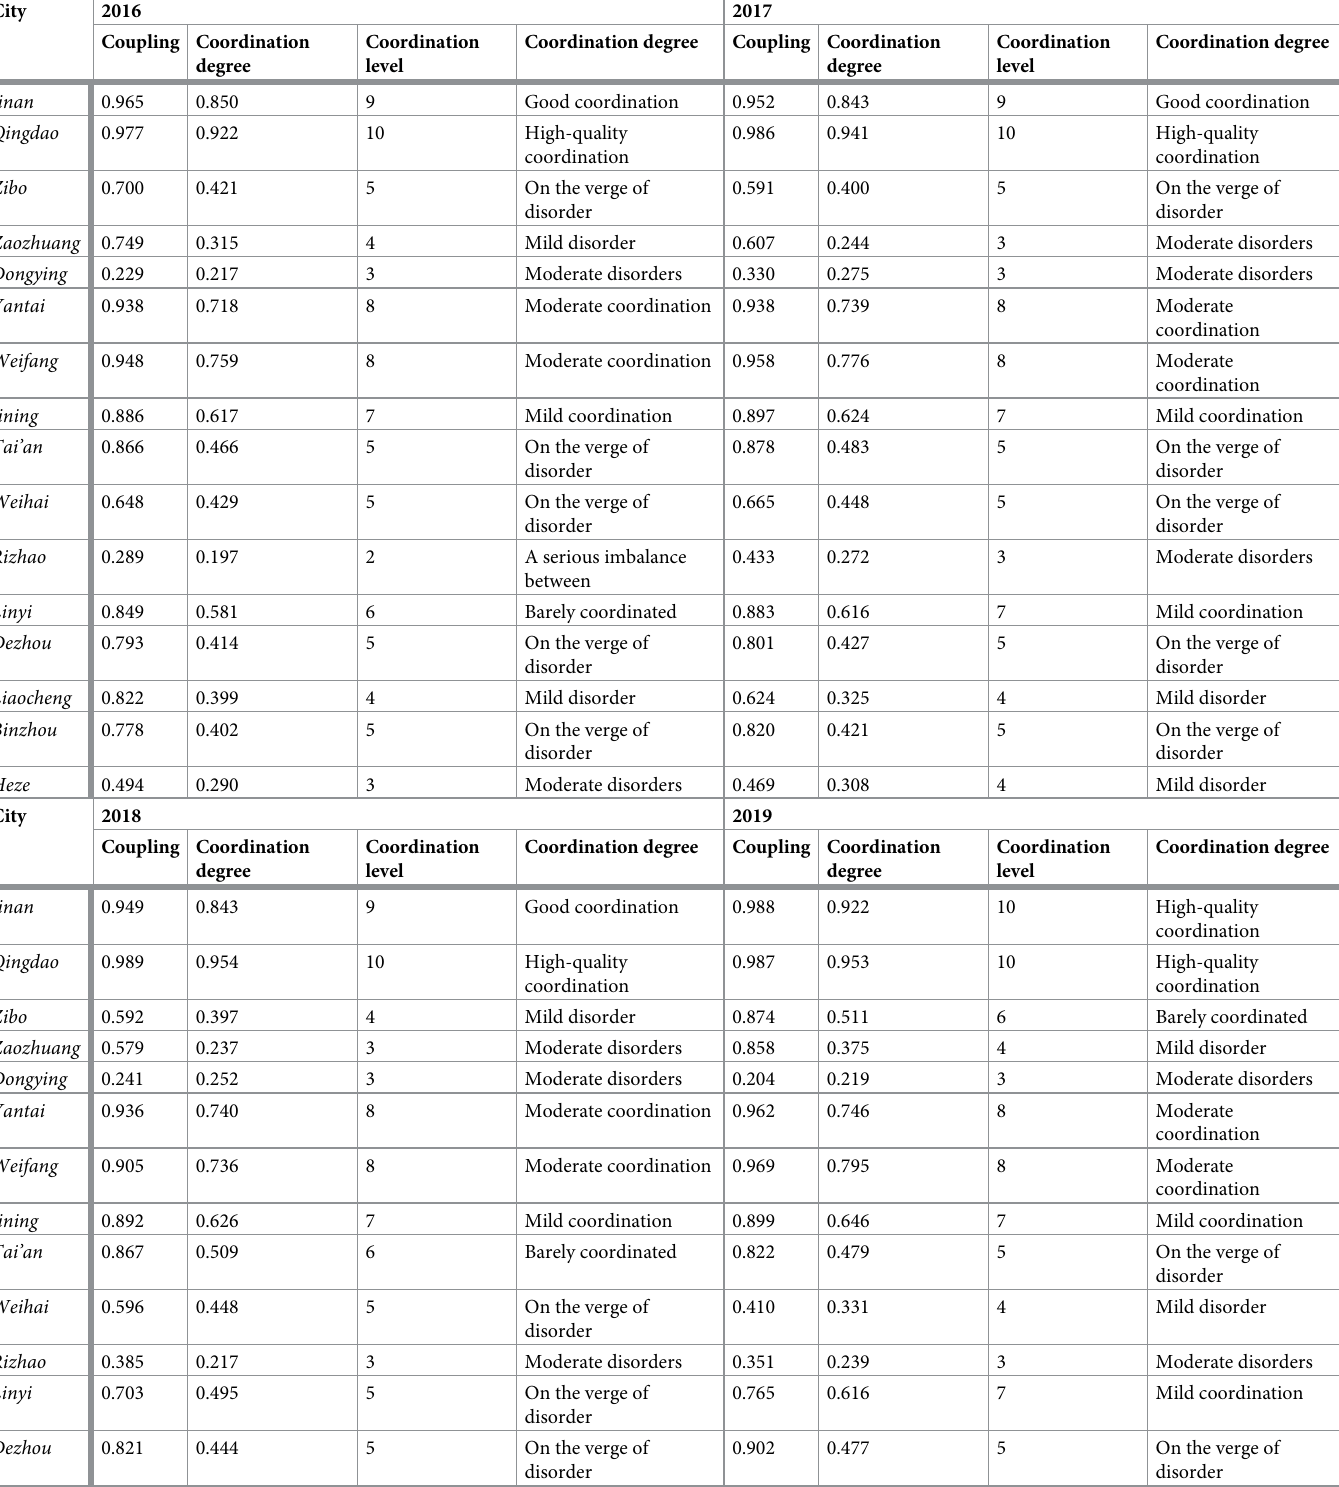
Table 8. Coupling degree and coordination degree of urban agricultural informatization and agricultural economic development in Shandong Province.